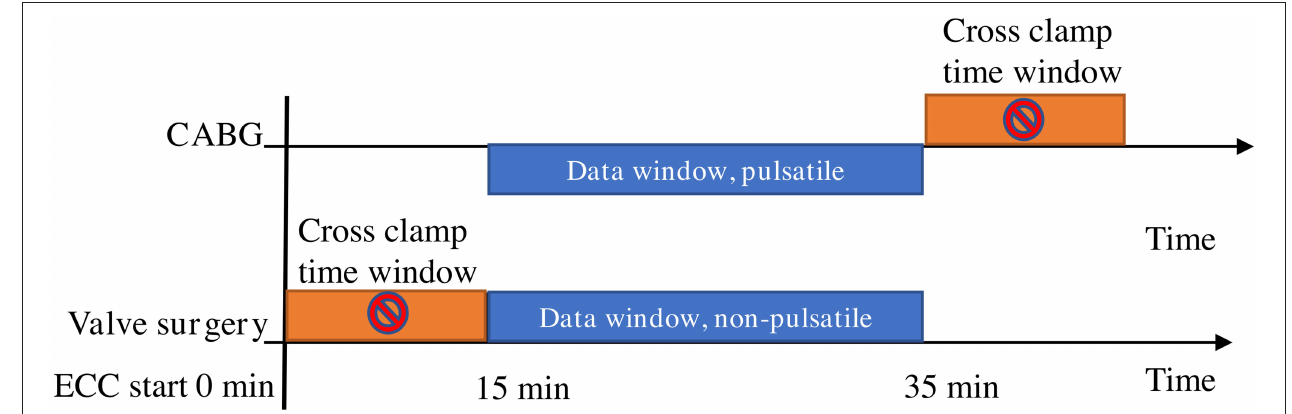
FIGURE 1 | Aortic cross-clamp data window preparation. The window time period is the same for the CABG cohort and the valve surgery cohort, such as 15min after the start of extracorporeal circulation. In the CABG group, the flow is pulsatile in the data window, and in the valve surgery group, it is non-pulsatile, since the aortic cross-clamp has been